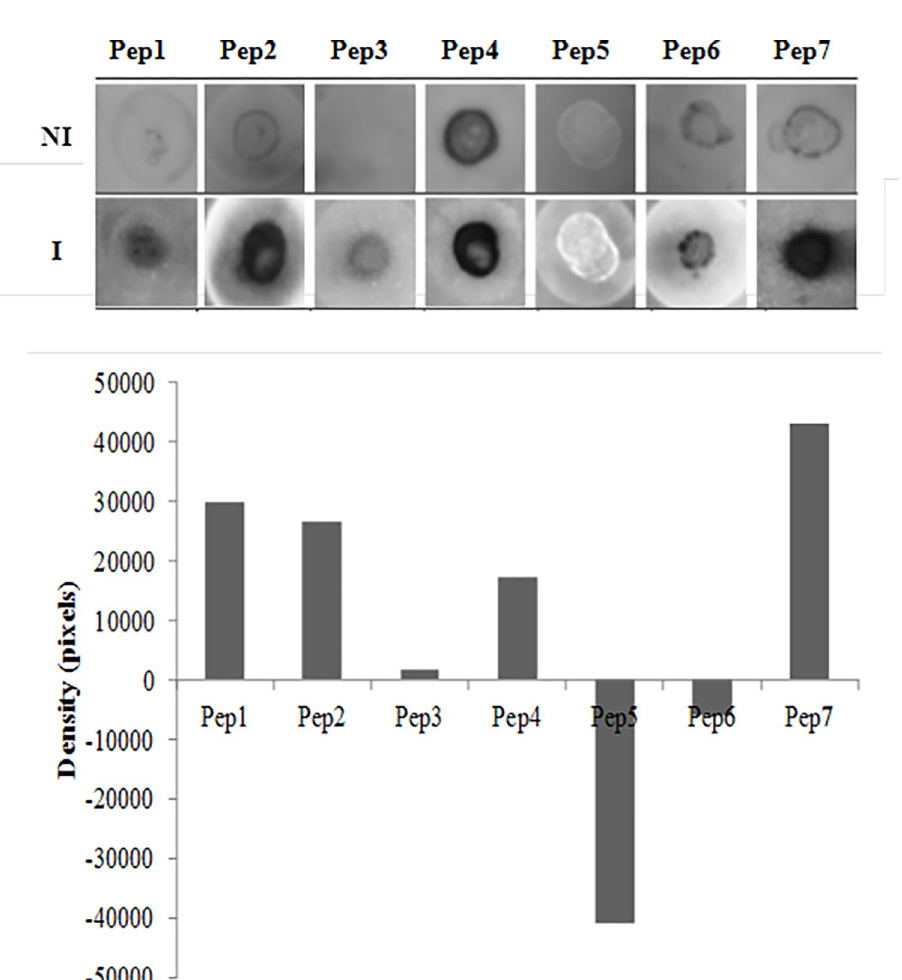
Fig 3. Recognition of peptides by antibodies in the sera of immunized hamsters. a) Dot Blot assay were set up with peptides bound to the membranes for interaction with sera from hamsters immunized with inactivated low-LPS vaccine (I) or non-immunized (NI). b) Quantification of the intensity of the spots by Image J